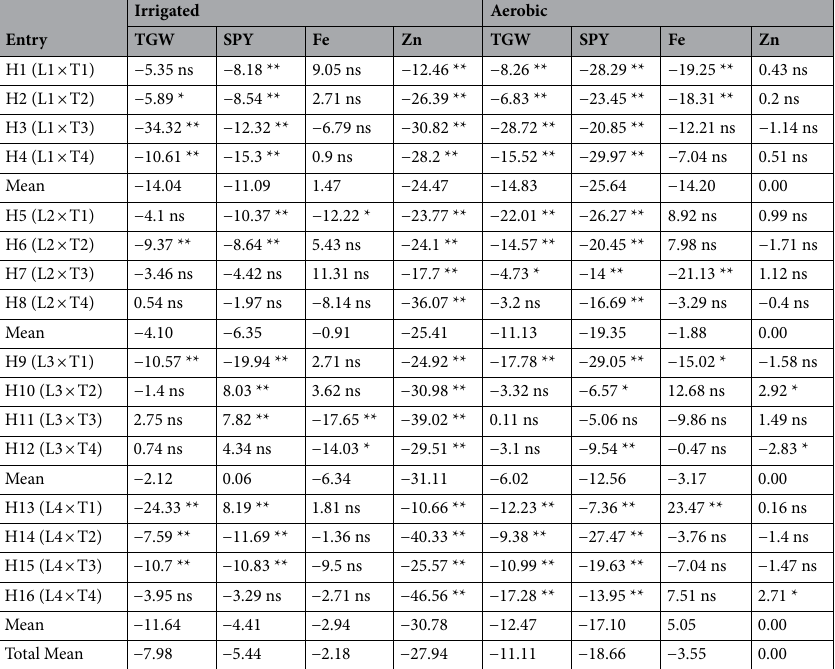
Table 7. Estimation of standard heterosis (SH) for yield components (TGW and SPY), grain Fe and Zn concentration of crosses (Hybrids) in irrigated and aerobic method. *P < 0.05; **P < 0.01; ns—not